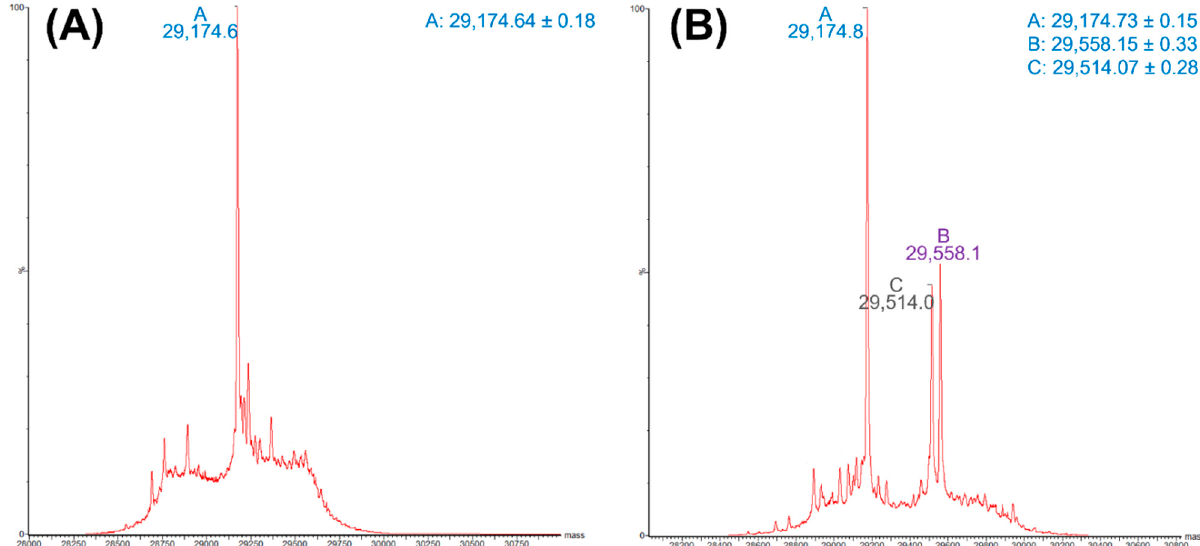
Figure 5. Analysis of interaction between OXA-48 and meropenem by ESI-MS: ( A ) mass spectrum of denatured OXA-48, mass at 29,174.6 Da; ( B ) mass spectrum of denatured OXA-48 after incubation with meropenem, apo OXA-48 (29,174.8 Da), and two meropenem binding product (29,514.0 Da and 29,558.1 Da).